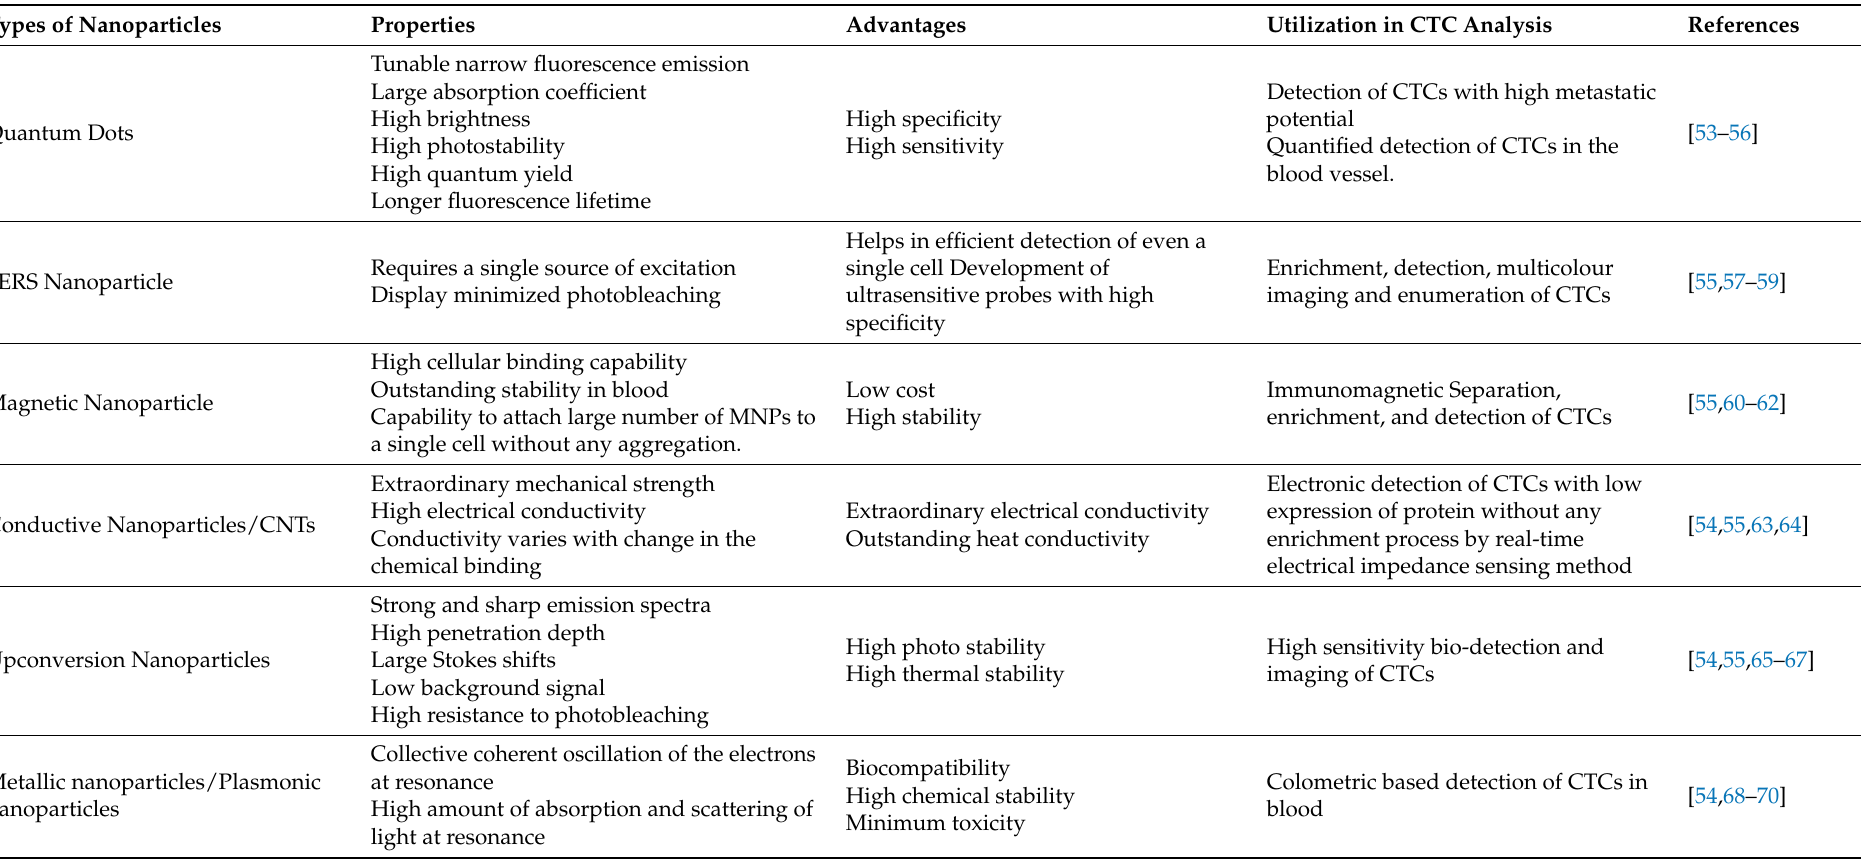
Table 1. Different types of nanomaterials used for the detection of